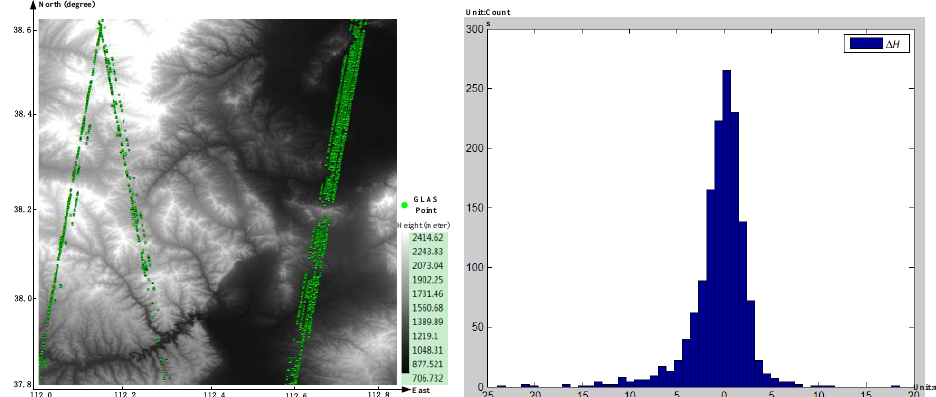
Figure 1. (a) Geo-location illustration of the ZY-3 DSM dataset and GLAS points in Weinan, western China; (b) statistical histogram of the differences in height between the two datasets.